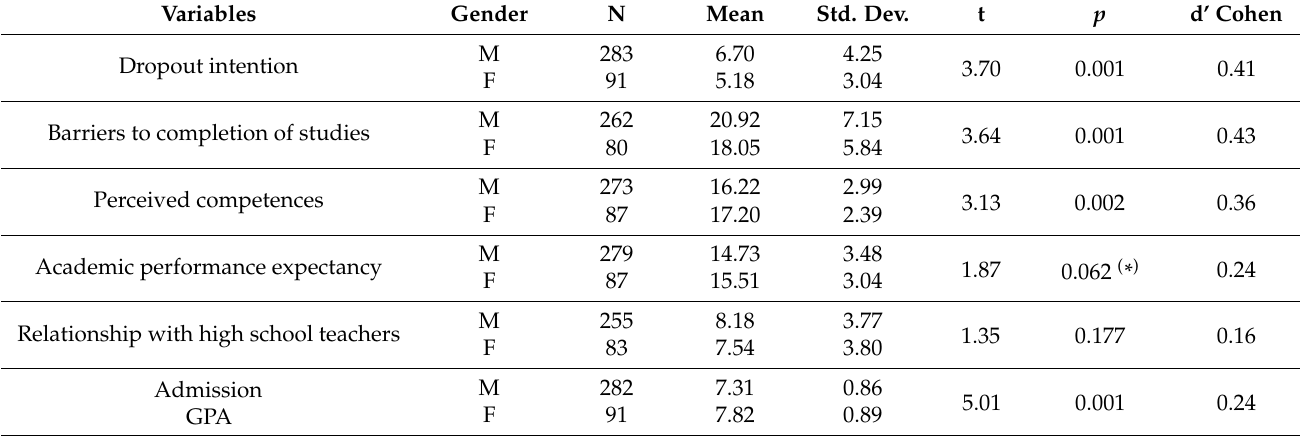
Table 2. Gender differences regarding intention to drop out and other investigated variables (H2). Variables